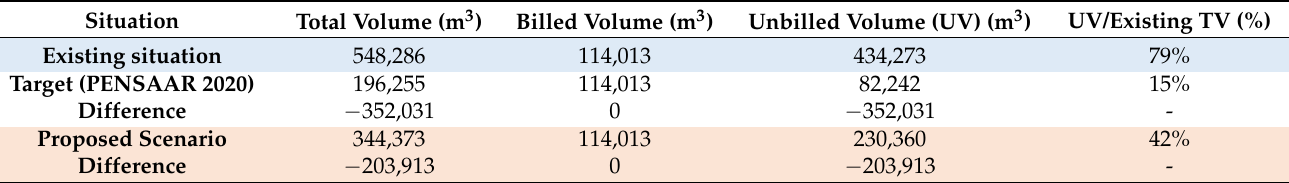
Table 7. Annual volumes in the Gaula WDN.